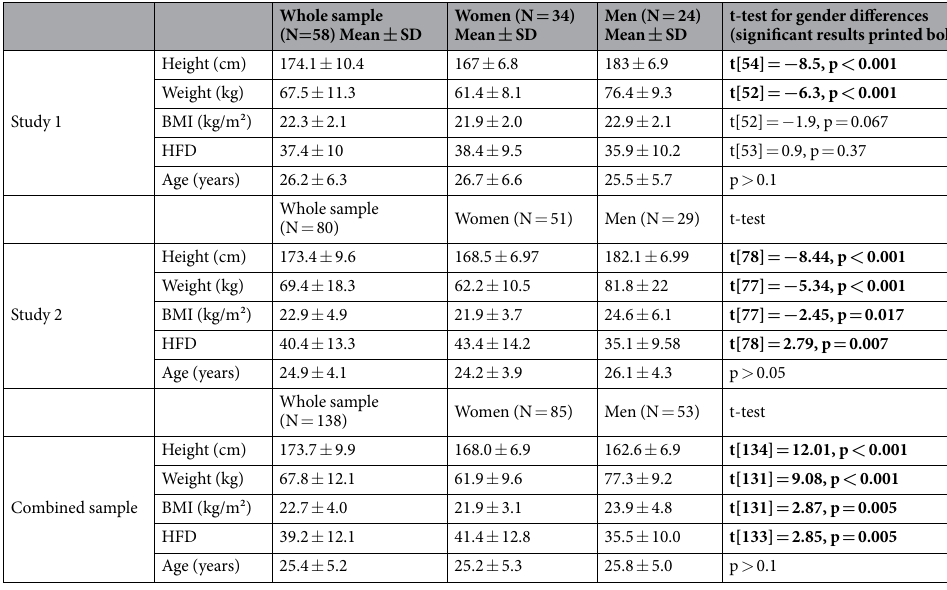
Table 1. Gender-specific demographic features of the sample groups of study 1 and 2 and the combined